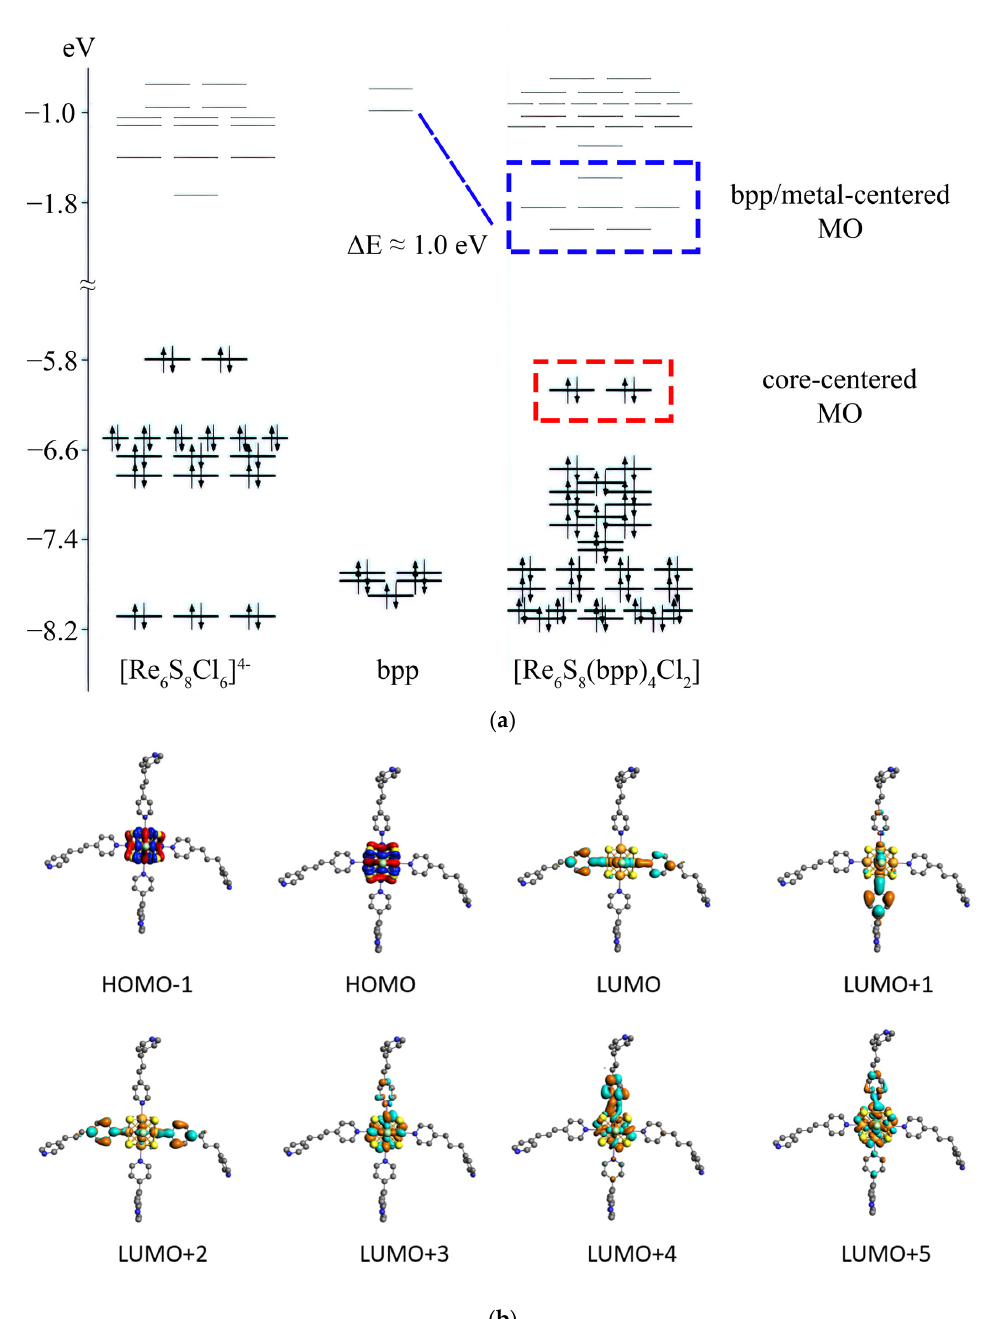
Figure 8. Energy levels diagram for the [Re 6 S 8 (bpp) 4 Cl 2 ] cluster in comparison with energy levels of [Re 6 S 8 Cl 6 ] 4– cluster anion and bpp molecule ( a ); molecular orbitals of the [Re 6 S 8 (bpp) 4 Cl 2 ] cluster anion in near frontier region ( b ). Isosurface isovalue is 0.03 a.u.